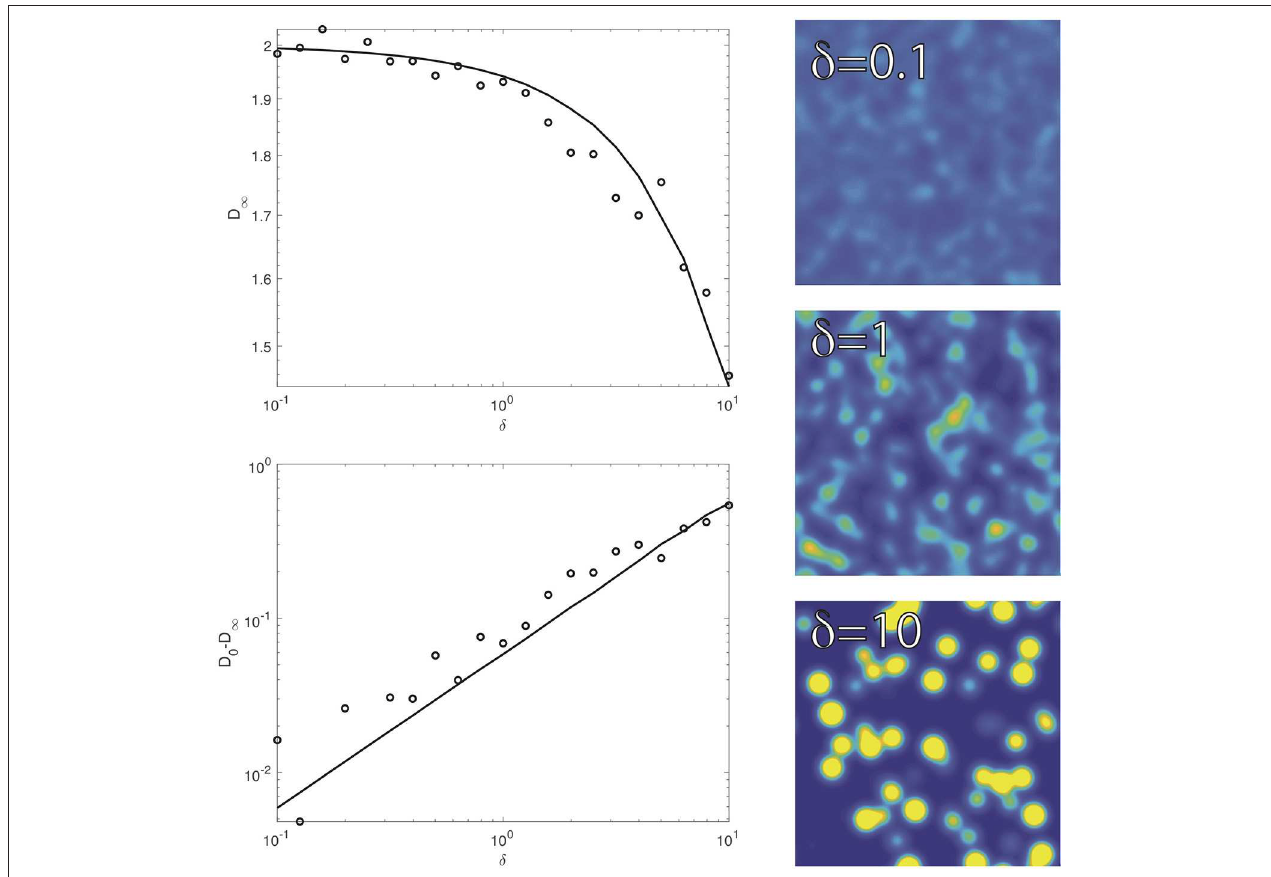
FIGURE 3 | The long-time diffusivity D solid curves show our analytical theory, and the dots give results from numerical simulations. The right images show realizations of the heterogeneous diffusivity over the range of δ in the plots (same color scaling as Figure 2 ). shown as a dashed line, where D